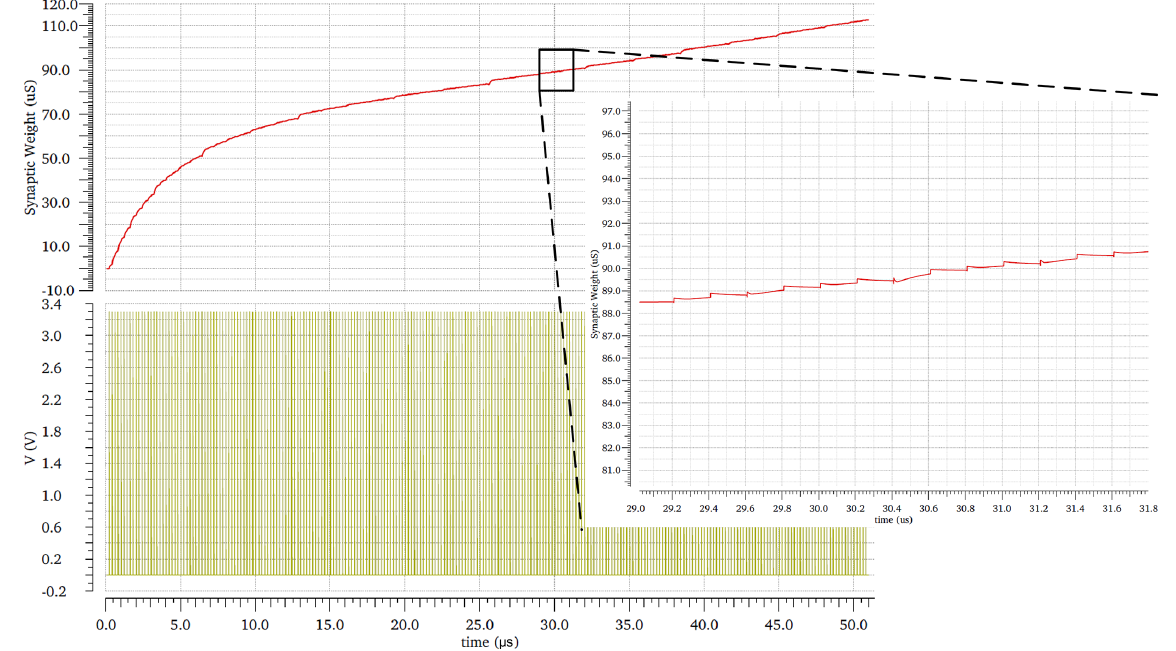
Figure 28. The synaptic weight behavior LTP at vg1 equals 1V, which is achieved by 256 input pulses applied to the 8bit counter, whose outputs control the 8bit binary digitized transistor of the synapse. Circuit conditions are V dd of 3 . 3V, and temperature equals 27 ◦ C and on the nominal process. The vg2 has a same influence on the second synapse of